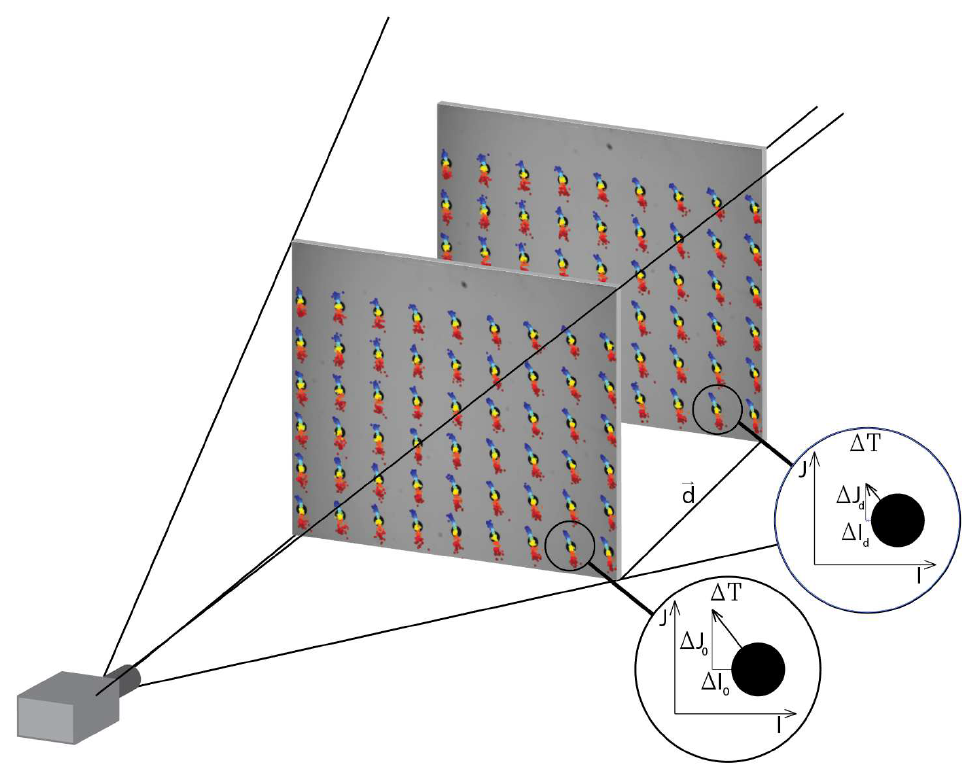
Figure 10. The deviations ∆ I 0 and ∆ J 0 caused by temperature drift ∆ T will cause a change in ∆ I d , ∆ J d for every position d of the calibration artifact. The compensation proposed for 2D images is valid for the entire field of view of the